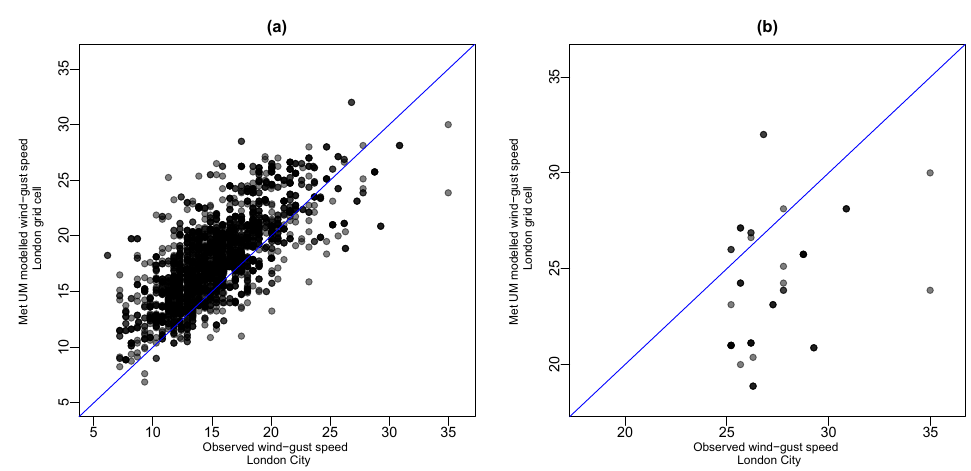
Figure 2. (a) The relationship between MetUM windstorm footprint wind gust speeds in the London grid cell and the corresponding observed wind gust speeds at the London City Airport weather station within the Global Summary of the Day data set, and (b) the same relationship for the 50 most extreme windstorm events at the London City Airport weather station. In both plots the line y = x has been added for reference